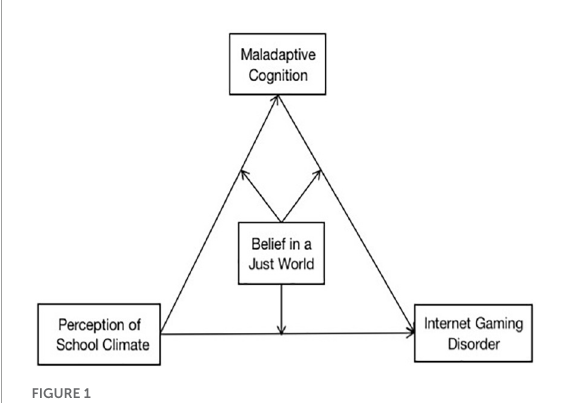
FIGURE1 The conceptual diagram of moderated mediation model based on research hypothesis.